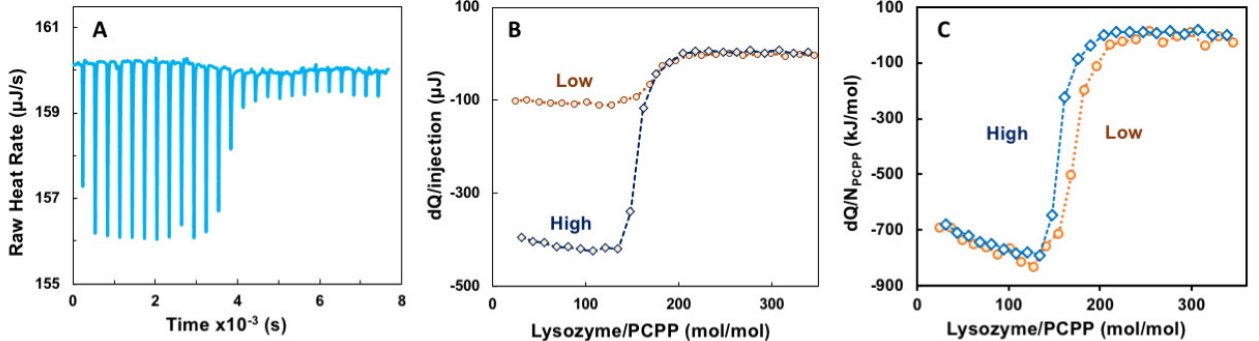
Figure 1. ITC data for the binding of lysozyme onto PCPP (direct titration). ( A ) raw data, ( B ) incremental heat per injection and ( C ) ITC isotherm for two different concentrations of reactants (0.125 ( A – C ) and 0.5 mg/mL ( B , C ) PCPP solutions were titrated with 2.5 and 10 mg/mL solutions of lysozyme, correspondingly. Concentrations are shown in Figures as “High” (blue, diamonds, dotted line) and “Low” (brown, spheres, pointed line); PBS, pH 7.4).